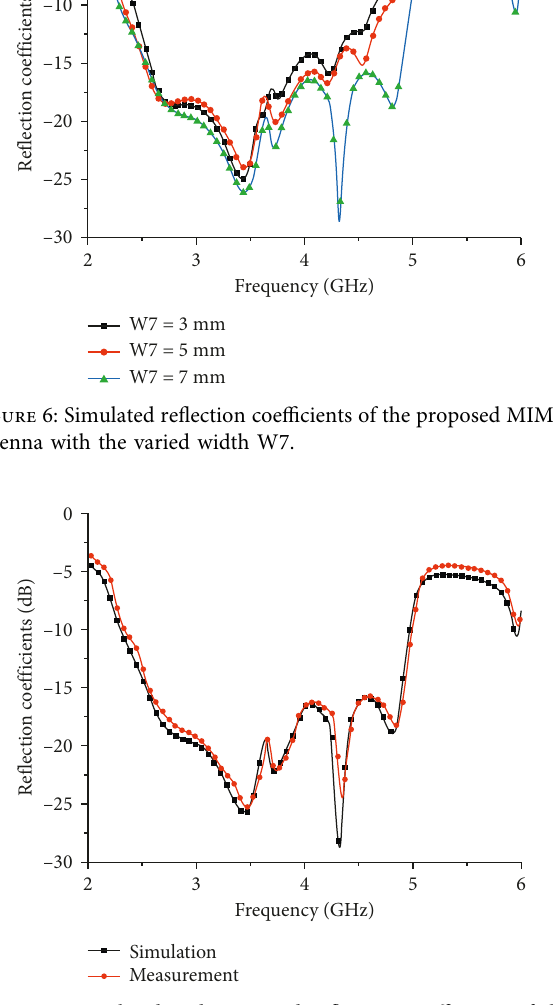
Figure 9: The simulated and measured isolation performance of the MIMO antenna with